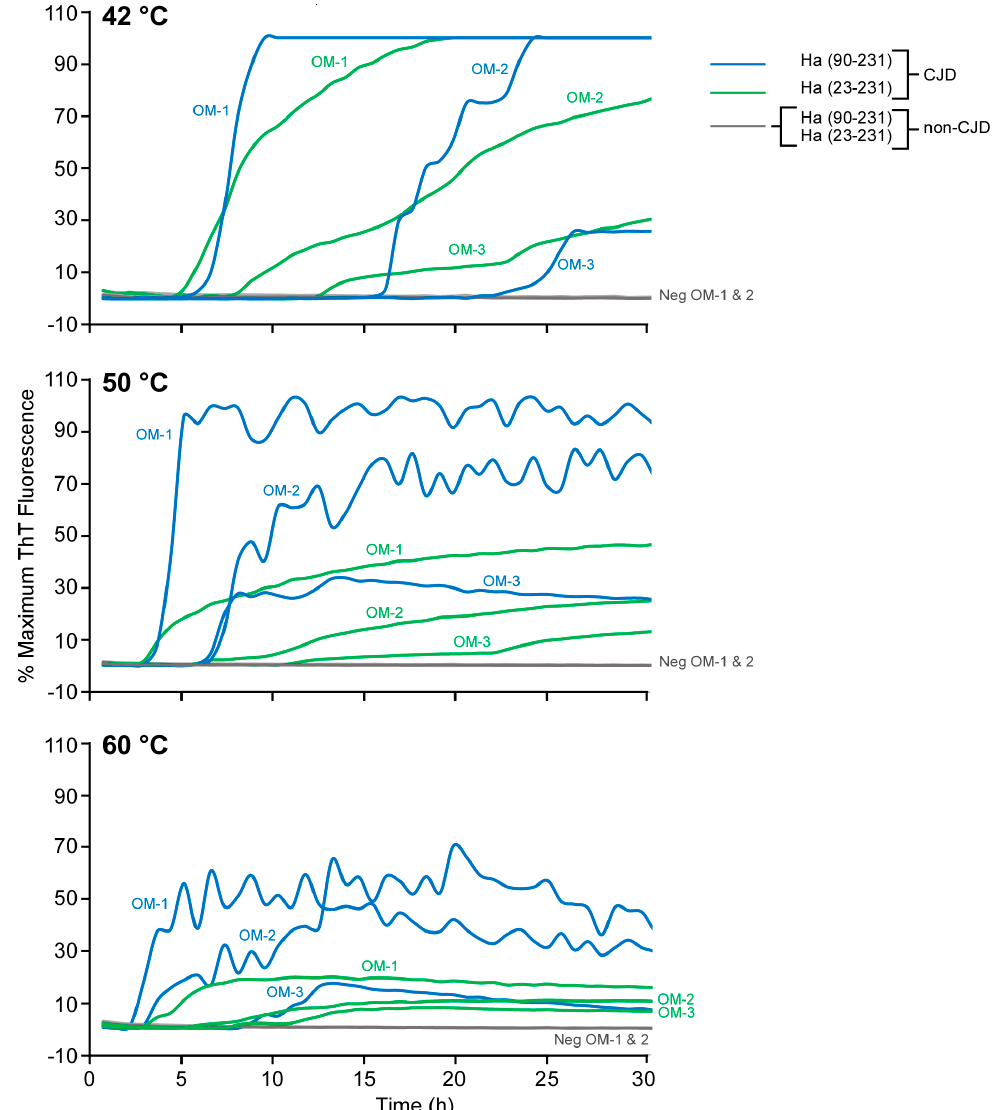
Figure 4. RT-QuIC detection of seeding activity in olfactory mucosa samples (OM) from human sCJD patients using Ha 23–231 or Ha 90–231 rPrP Sen substrates at 42, 50 and 60 °C. Olfactory mucosa samples from three sCJD (OM 1, 2 and 3) and two non-CJD patients (Neg OM 1 and 2) serially diluted to 4 × 10 − 5 tissue dilutions were used to seed quadruplicate reactions with either Ha 90–231 (sCJD blue lines; uninfected gray) or Ha 23–231 (sCJD green lines; uninfected gray) rPrP Sen as substrates. Replicate reactions were incubated at the indicated temperatures. The increase of the average normalized ThT fluorescence of replicate wells ( y -axis) is plotted as a function of time ( x -axis).